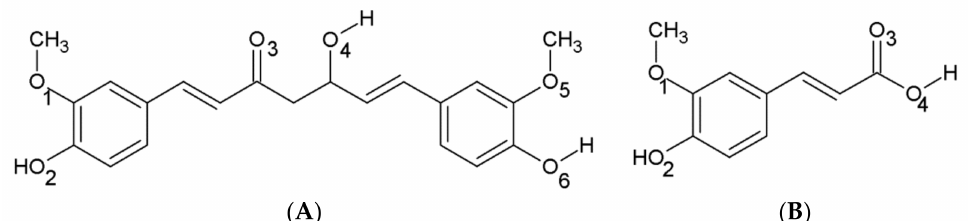
Figure 1. Chemical structures of the amyloid-beta (A β ) inhibitors ( A ) curcumin (CU) and ( B ) ferulic acid (FA). The O-atoms in the molecules are